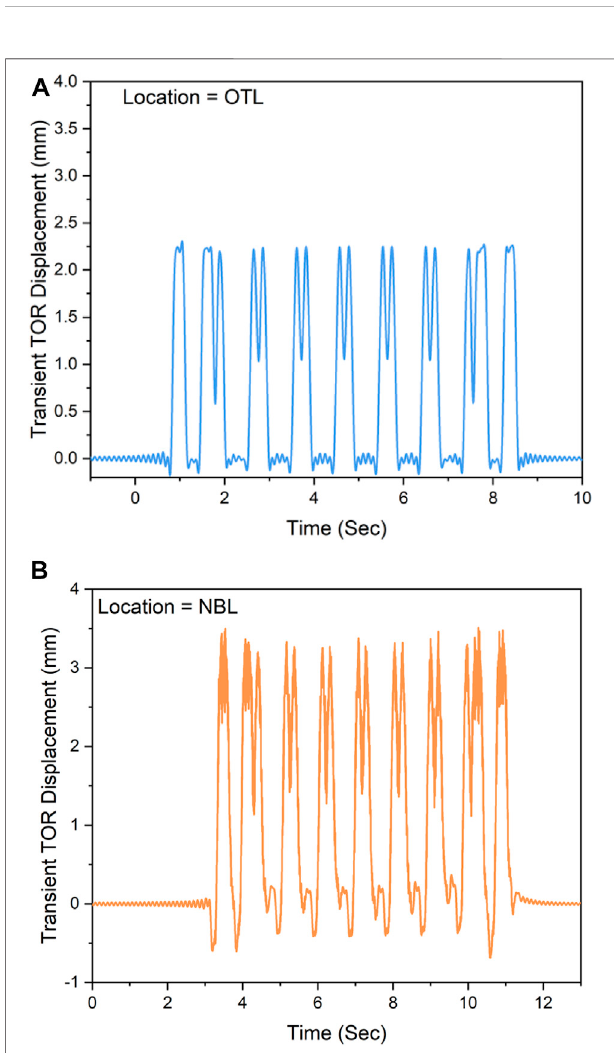
FIGURE 6 | Model-predicted transient rail displacement time histories under the passage of a freight train comprising Gondola cars only (speed of operation (cid:1) 80.5 km/h): (A) OTL; (B) NBL.